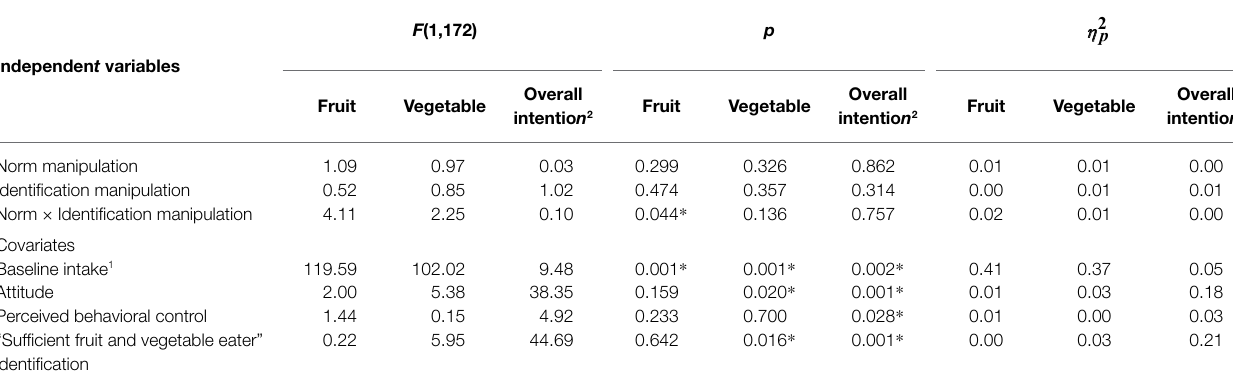
TABLE 5 | ANCOVA table for fruit and vegetable intake intentions (Part 1).